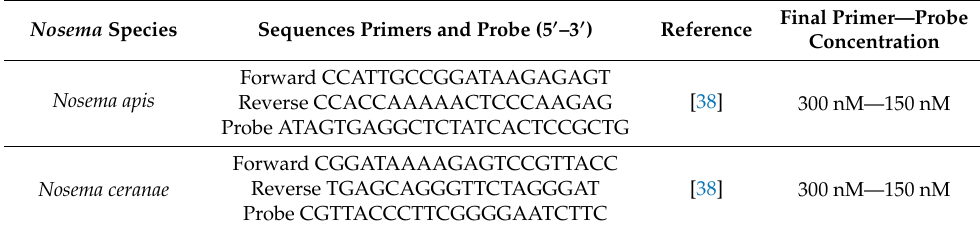
Table 2. Primers and probes used for real time PCR detection of Nosema apis or Nosema ceranae .